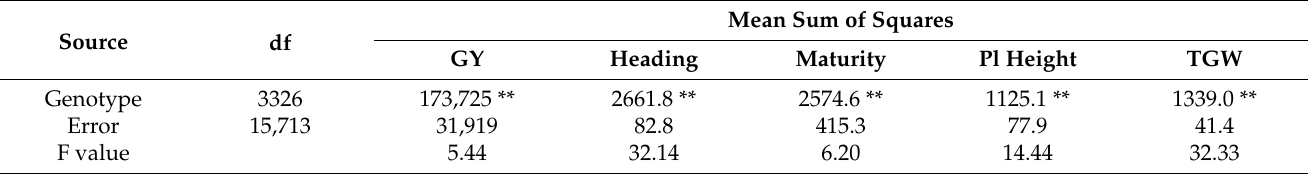
Table 1. Analysis of variance of five traits in 3226 genotypes of wheat when evaluated under six locations of India under early (October) sowing